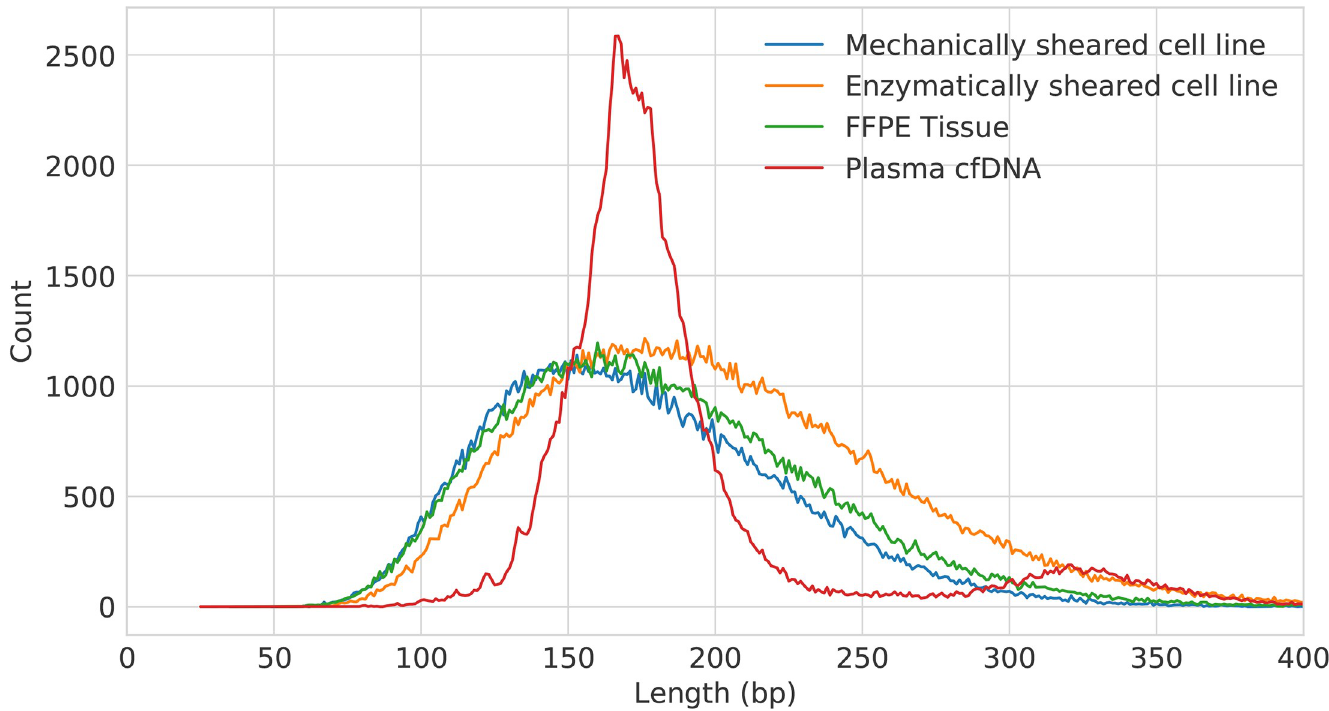
Fig 2. Representative insert size distributions for each sample type used in this study.